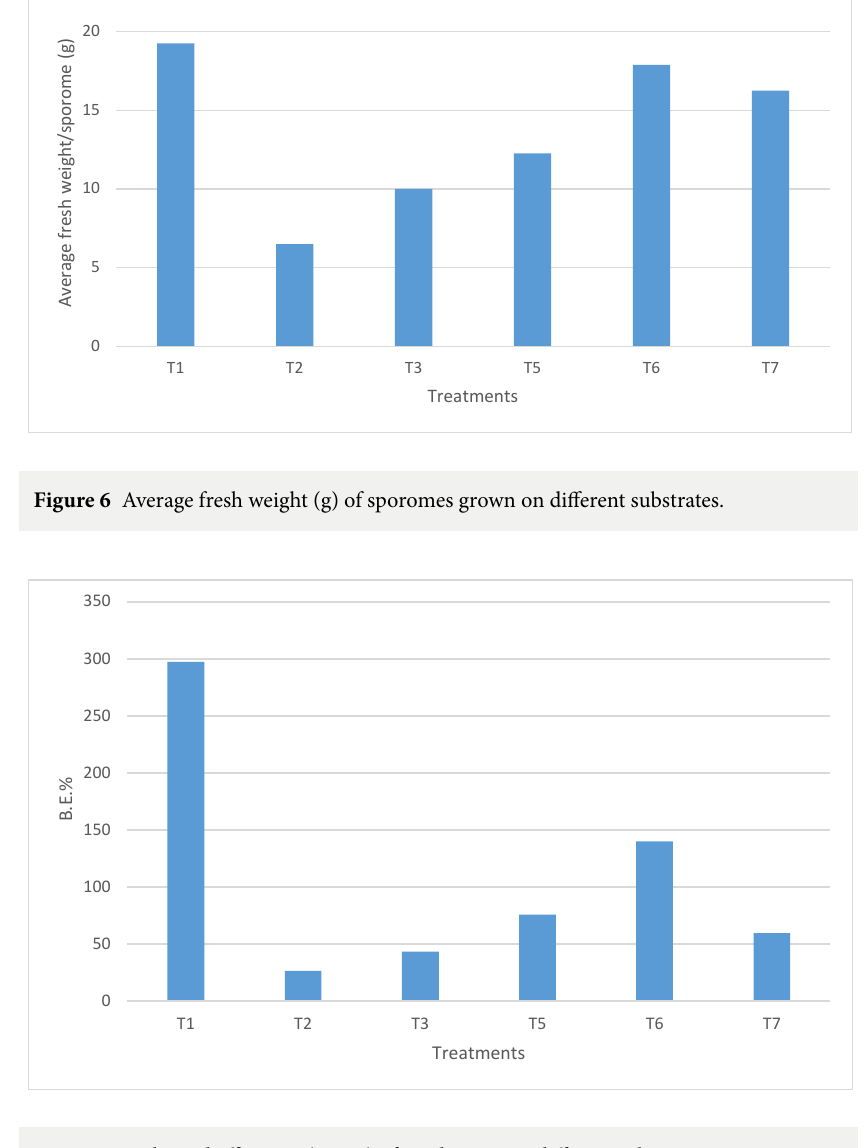
Figure 7 Biological efficiency (B.E.%) of production on different substrates.